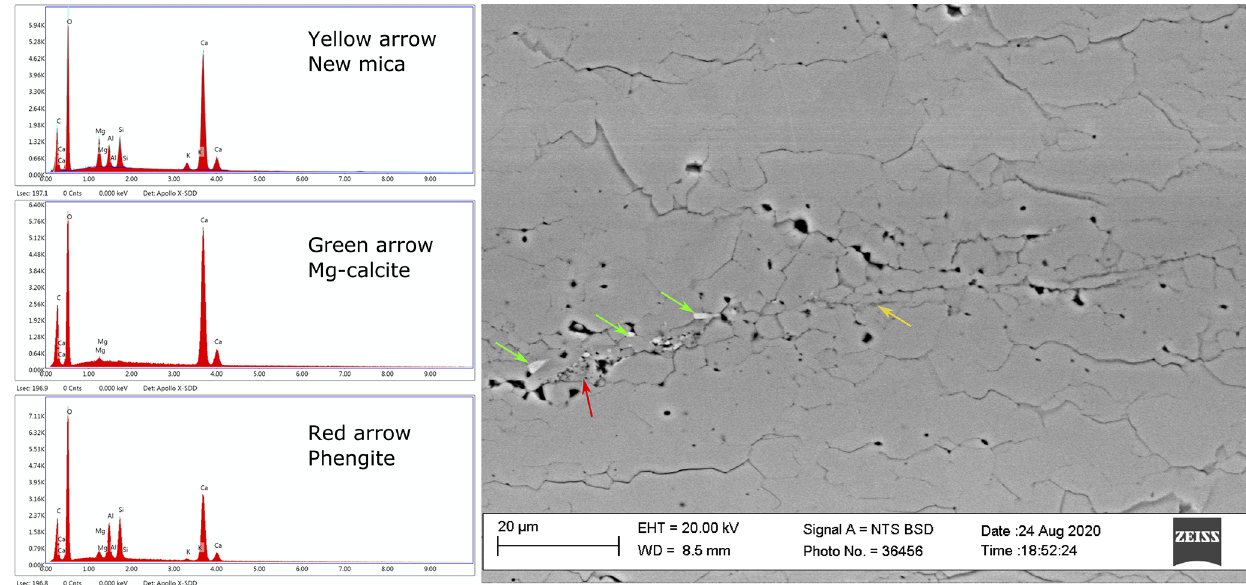
Figure A5. Energy dispersive spectroscopy (EDS) spectra of small precipitates in the pore sheet shown in Fig. 2 of the main